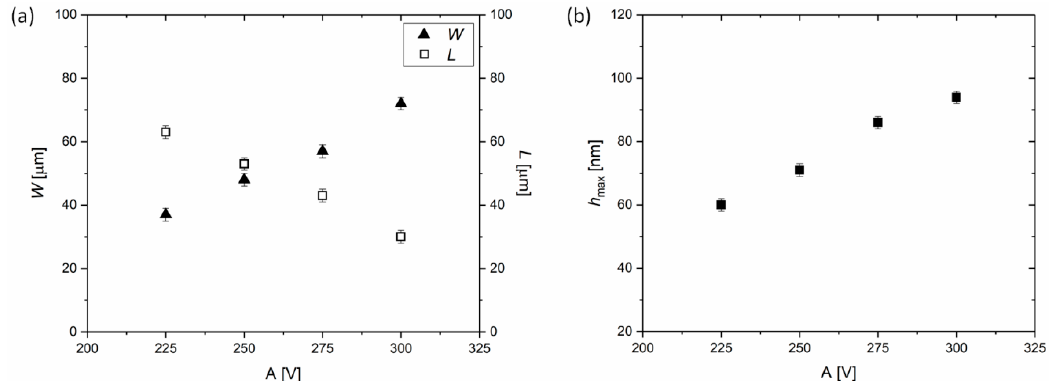
Figure 4. Influence of the amplitude of the applied voltage ( A ) on the geometrical features of the overprints on ( a ) width ( W ) and edge-to-edge distance, defining the channel length ( L ), and ( b ) maximum height of the overprints ( h max ). B = 200 V, f = 500 Hz, s = 100 μ m.